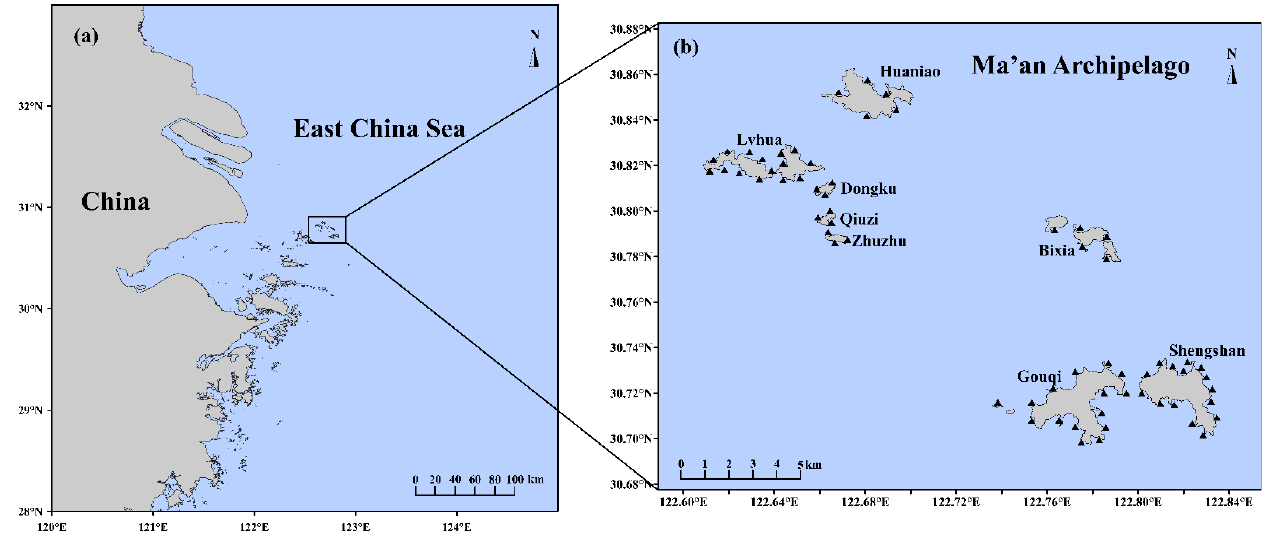
Figure 1. Investigation area. ( a ) Ma ’ an Archipelago is located in the Yangtze delta, China. ( b ) The eight representative islands in this survey. The triangles indicate the diving sampling stations.